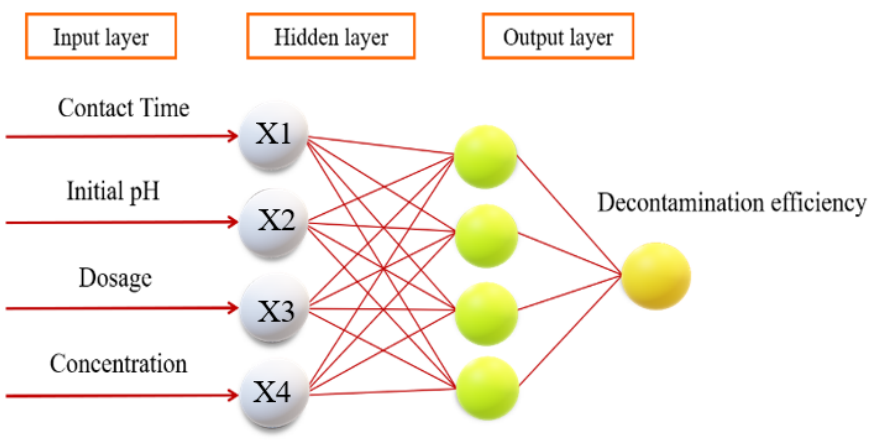
Figure 20. Mean square error (MSE) of the neurons in the BP-ANN model.